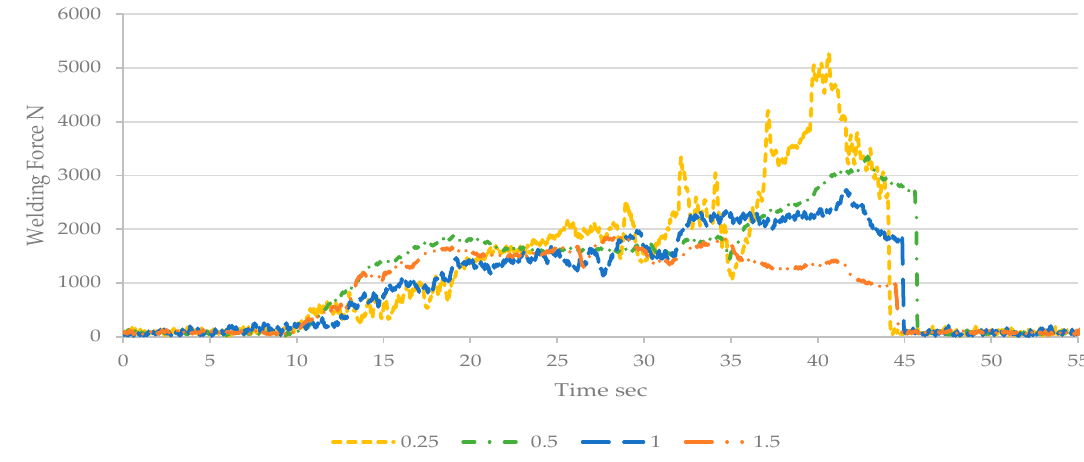
Metals 2021 , 11 , x FOR PEER REVIEW Figure 10. Effect of changing the spindle speed during the weld stroke on weld force from R DWP = 0.25 to 1.5.